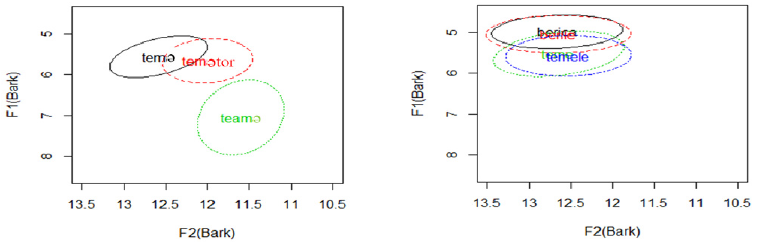
Figure 4. Acoustic characteristics of experimental (left) and control (right) stimuli in the F1xF2 dimension. Stimulus names are positioned to the centroid of each ellipsis. For the stress control and word length control pairs respectively, the two ellipses (and centroids) are on top of each other.